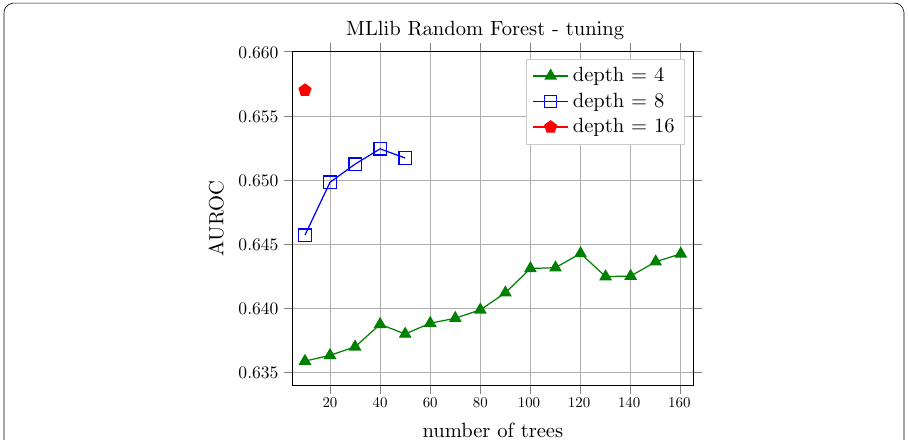
Fig. 7 Random Forest tuning. Performance (AUROC) with different parameter